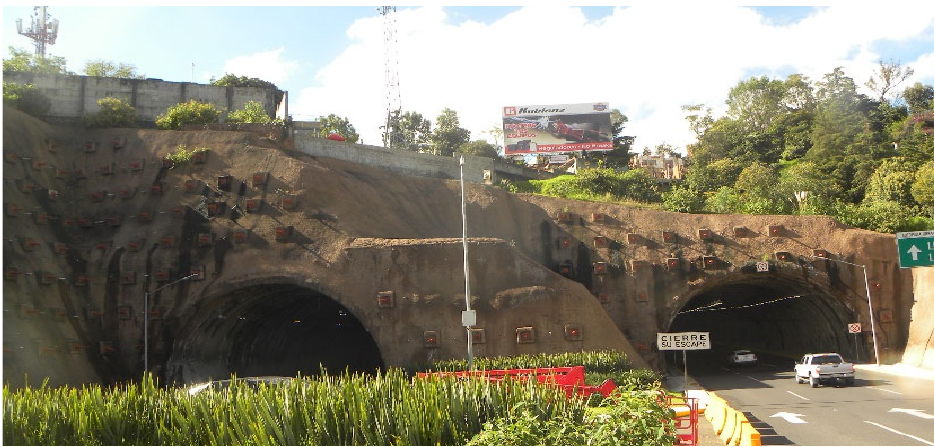
Figure 41. Panoramic view of the North Portal of el Desierto de los Leones Tunnel in 2020.